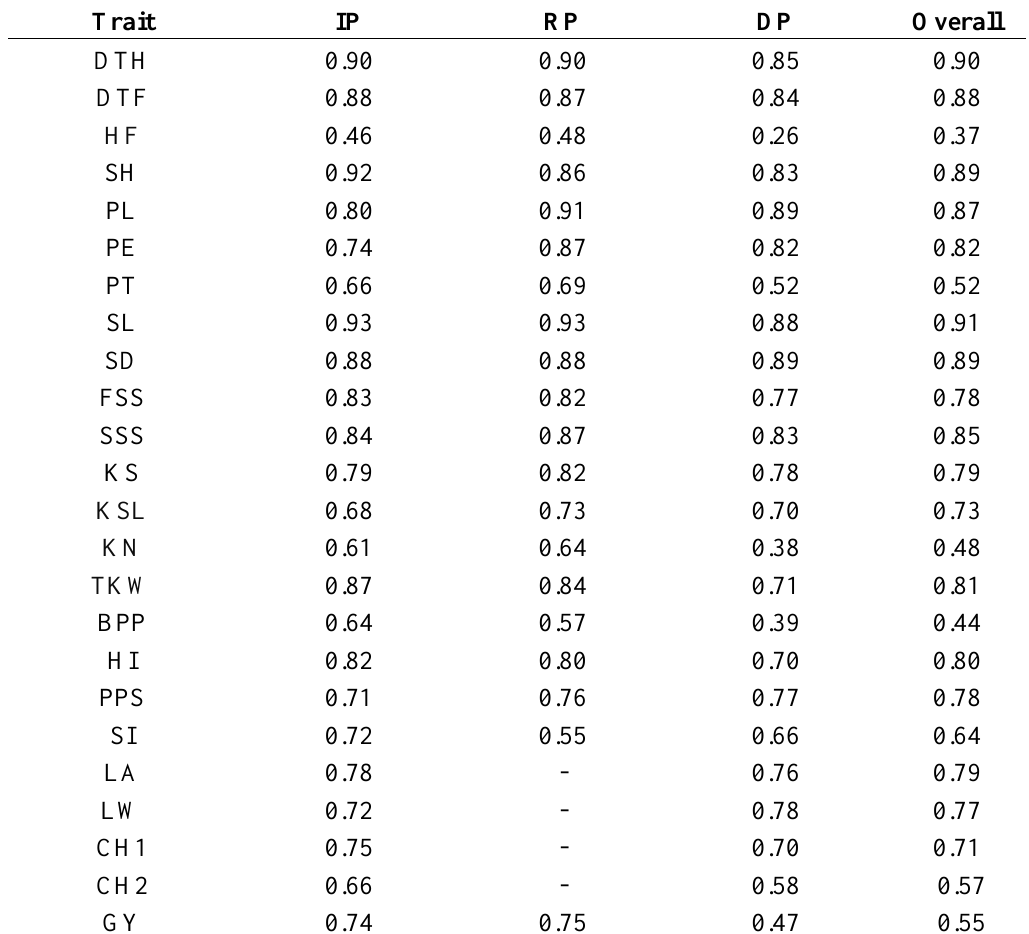
Table 2. Trait heritability in irrigated (IP), rainfed (RP) and drought (DP) plots (averaged over years) and overall (averaged over years and